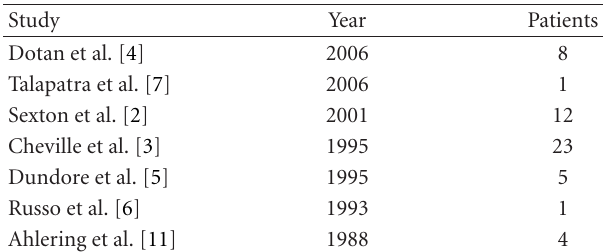
Table 1: 54 cases of primary prostate leiomyosarcoma included in this review.